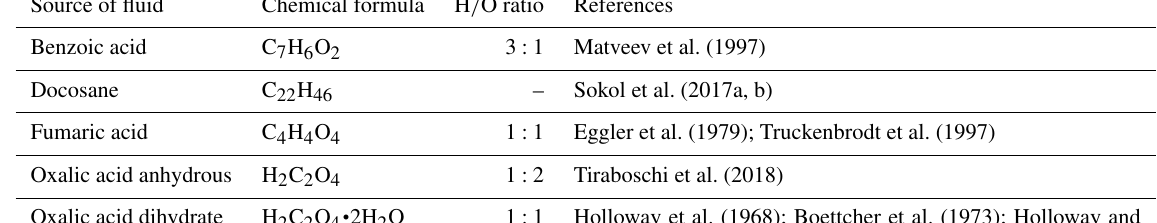
Table 1. Organic compounds employed in the literature to generate COH fluids in ex situ experiments. Source of